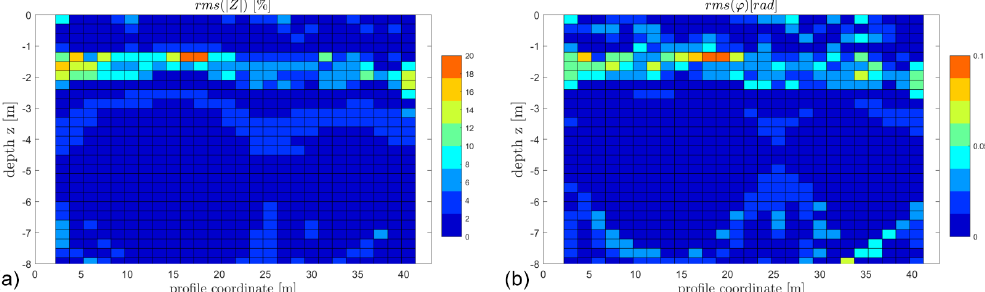
Figure 13. Data fit of the ice content estimation in terms of the root mean square for the magnitude | Z | (a) and the phase shift ϕ (b) . The values are displayed for every inversion cell over the 2-D